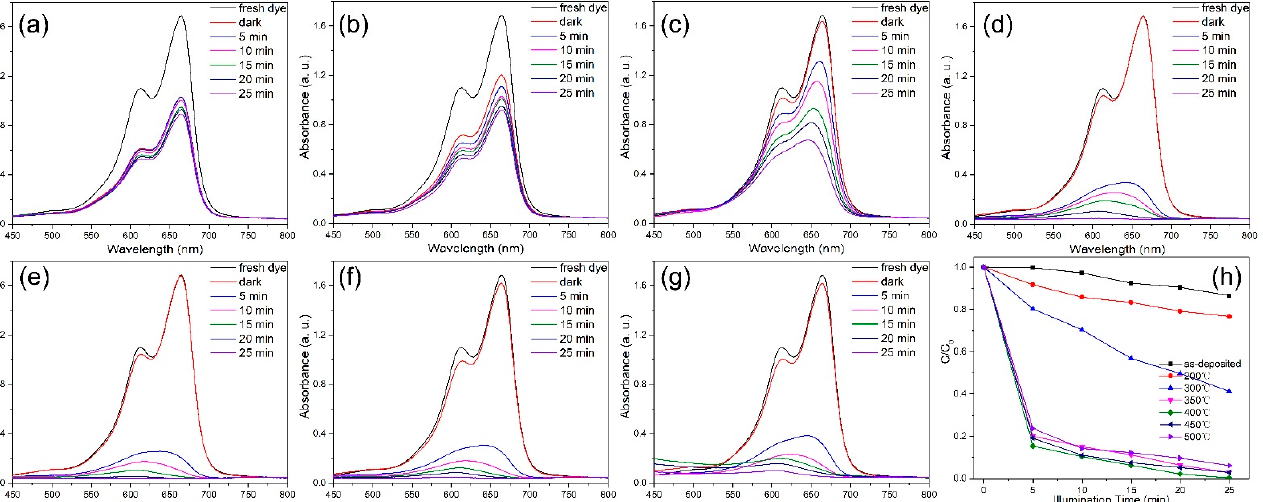
ics equation [33]: In ( C / C 0 ) = − kt , where k and t denote the degradation rate constant